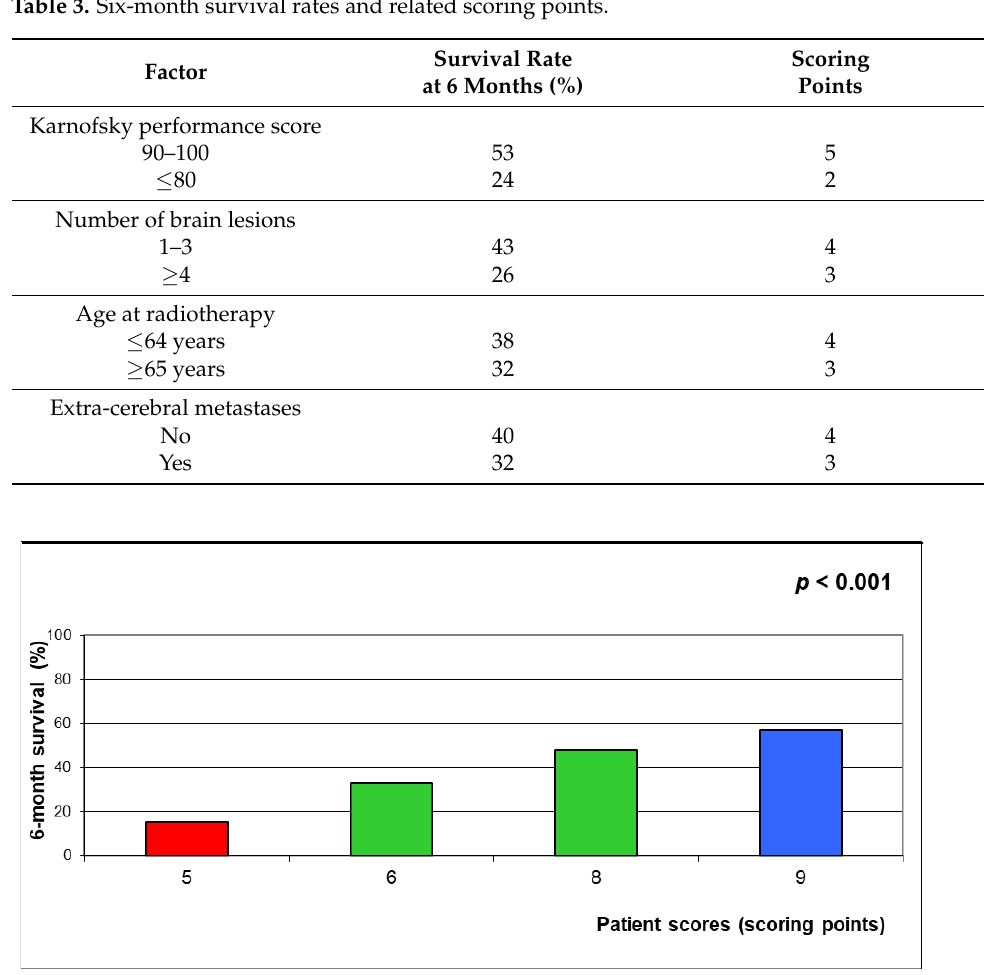
Figure 2. Model 1 (including KPS and number of lesions): Six-month survival rates of patient scores ranging between 5 and 9 points.